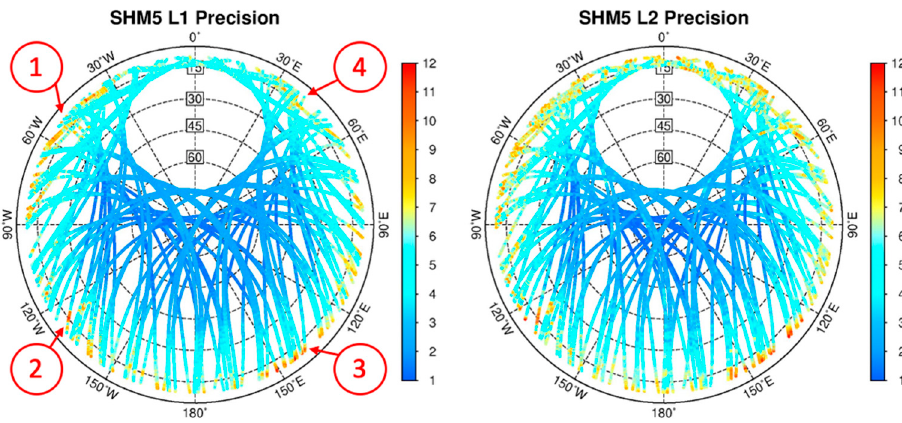
Figure 13. Carrier phase precision (mm) related sky-plot of GPS and GLONASS at SHM5.